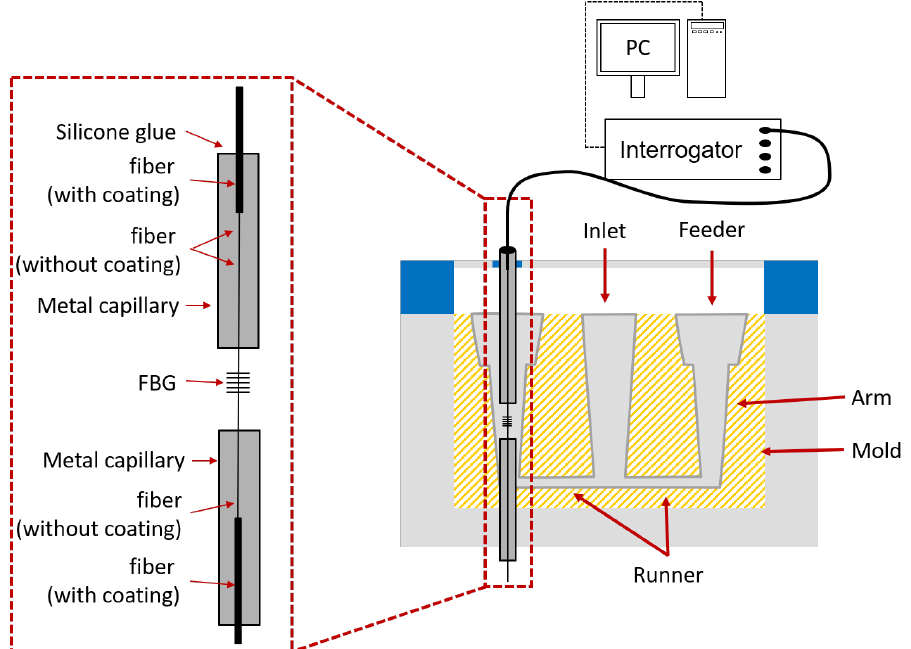
Figure 4. Casting setup with embedded FBG sensors. The bare fibers (smf28 or GF1B) with the FBGs get in contact with the aluminum and therefore the FBGs are sensitive to both temperature and temperature-induced strain of the aluminum.